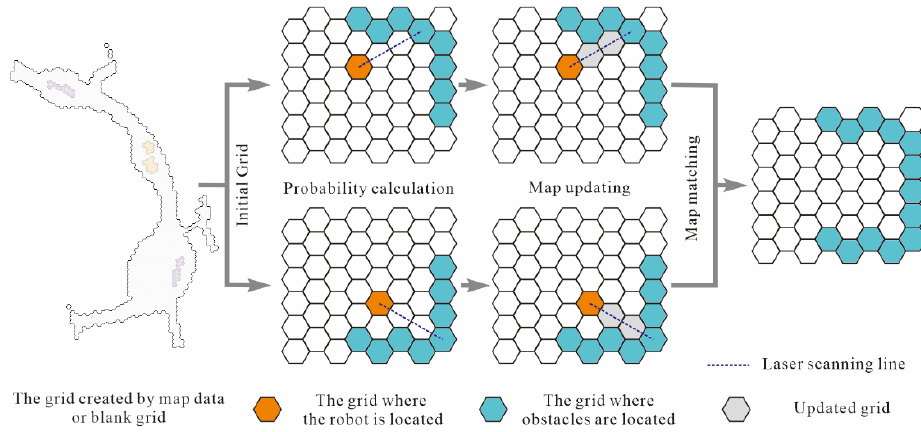
Figure 7. Regular hexagonal grid model construction process based on the laser sensor